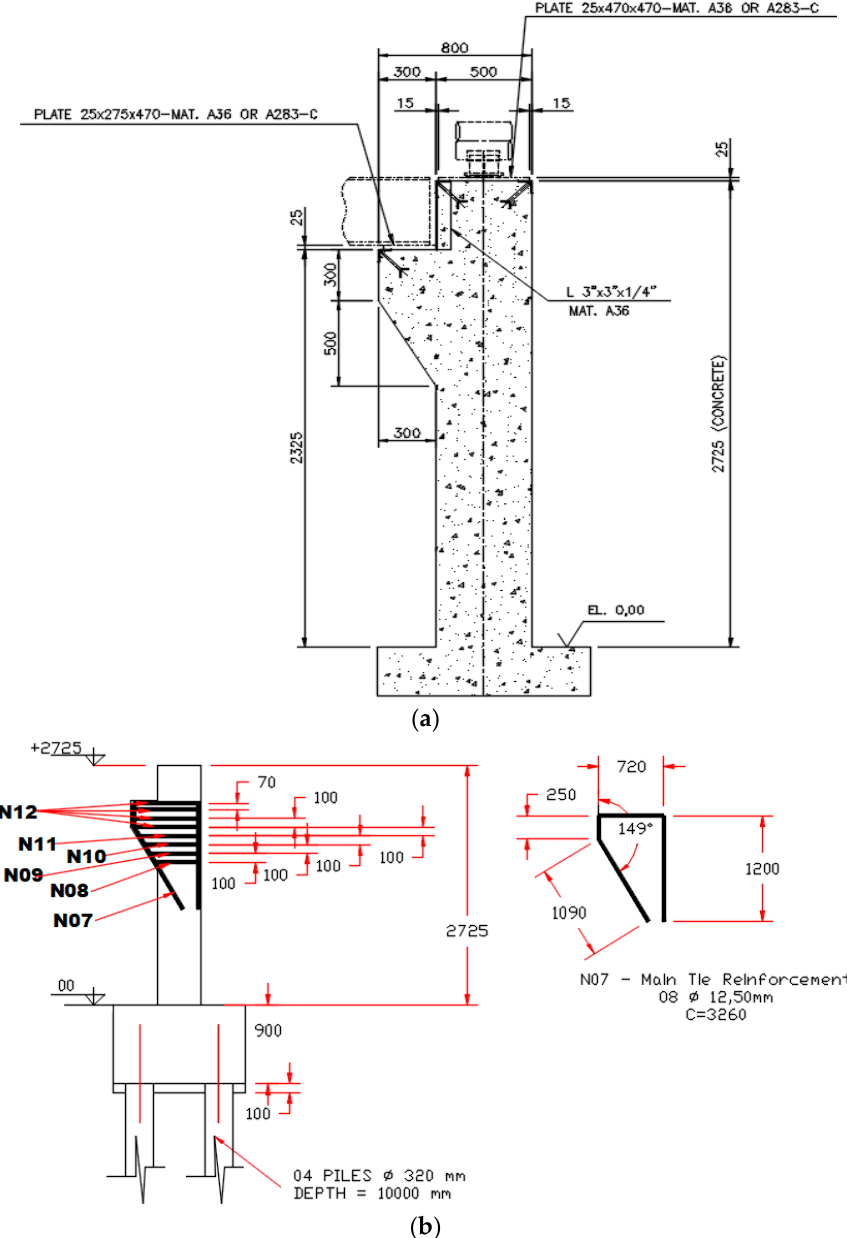
Figure 6. ( a ) Dimensions of the reinforced concrete corbel and column supporting the W ‐ beam and ( b ) main tie reinforcement found in the structural design shop drawings.